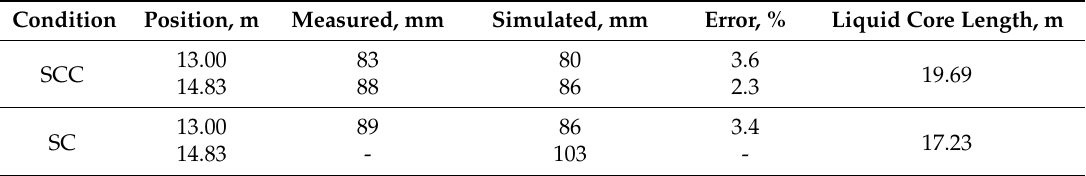
Table 4. Comparison of measured and simulated solidified shell thickness.